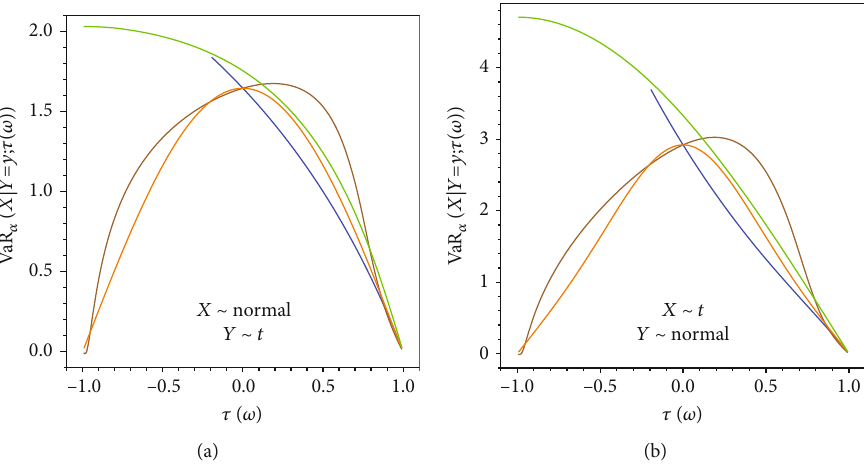
Figure 7: Conditional estimative VaR forecast, for X ∼ normal and Y ∼ t (a), also for X ∼ t and Y ∼ normal (b), against dependence measure τ ð ω Þ by using Gumbel (blue line), Clayton (brown line), Gaussian (yellow line), and t copulas. Table 4: The coverage probability of estimative VaR forecast of ARCH(1) process for several ( 1 − α ), ranging from 0.90 to 0.99.